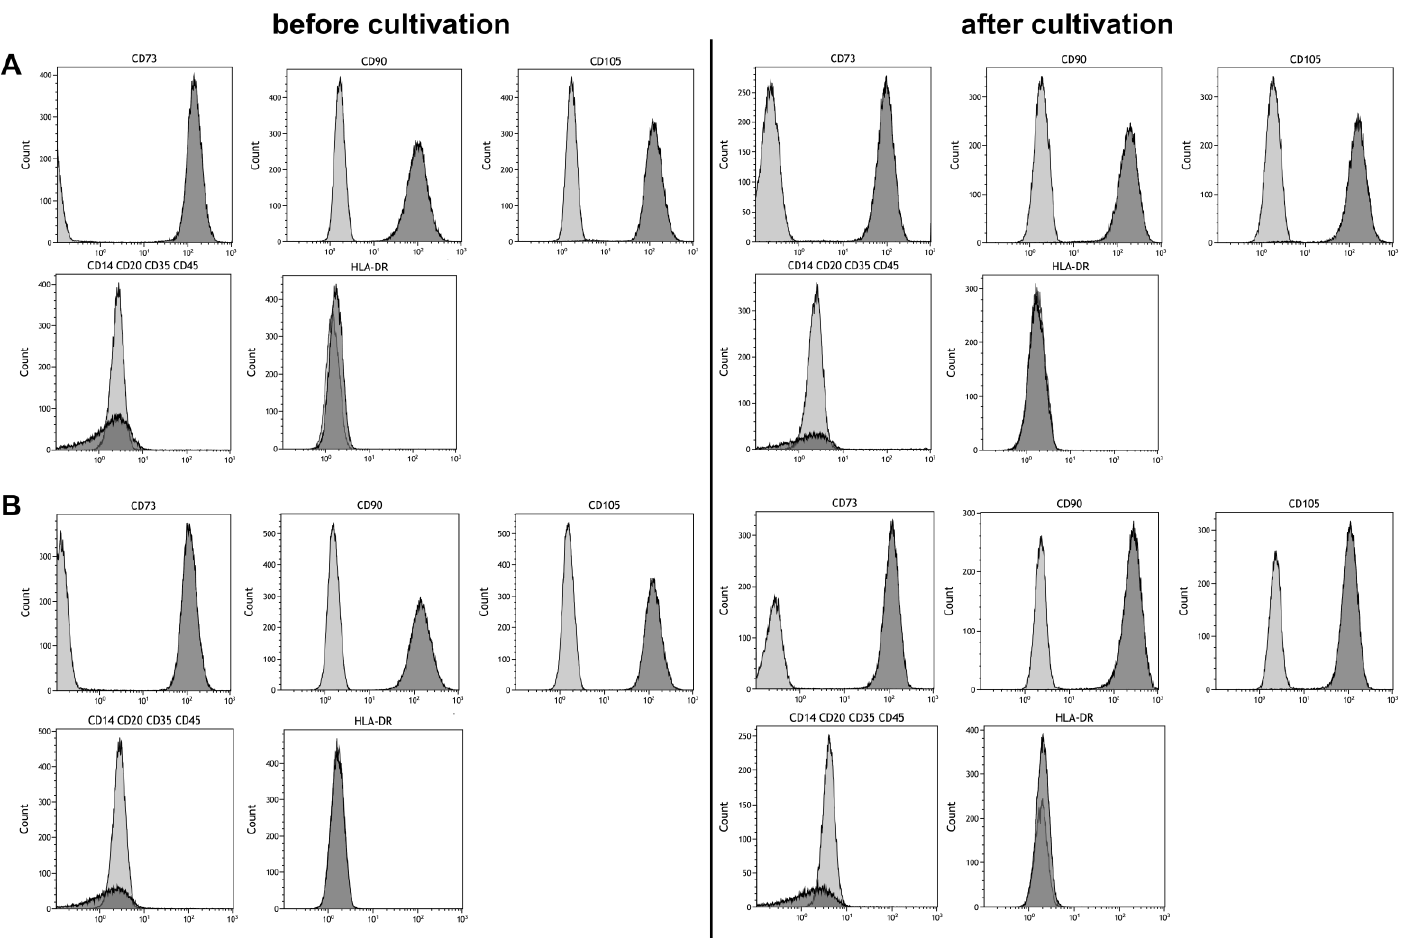
Figure 4. Phenotyping of mesenchymal stem cells before and after six days of cultivation under ( A ) 21% and ( B ) 5% O 2 in a continuously stirred tank reactor. Light gray areas indicate the isotype control, dark grey areas indicate the phenotype.